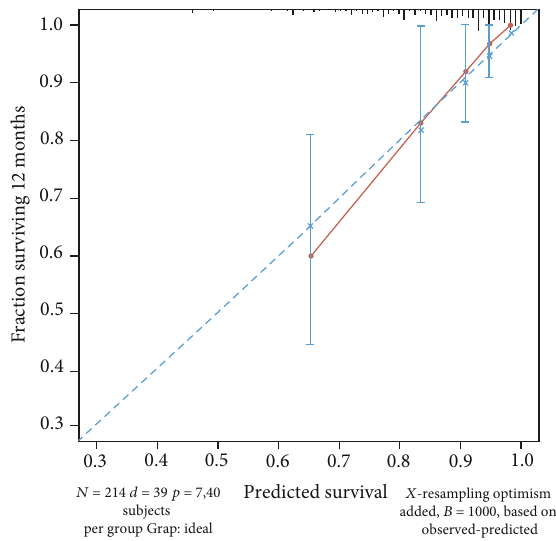
Figure 4: Receiver operating curve (ROC) of the nomogram at 1/3